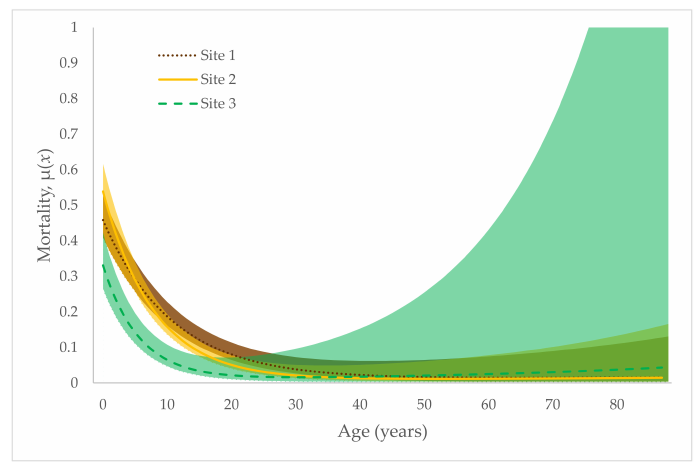
Figure 1. Mortality trajectories from germination for each site of Pulsatilla vulgaris ssp. gotlandica using the Gompertz bathtub model. Lines end where the population from the site with the lowest mortality (site 3) reaches 1% of its original size (Figure A1).